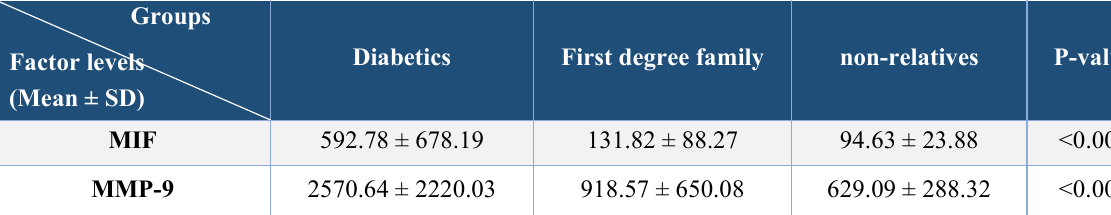
Table 1. Mean of factor levels in different study groups Groups